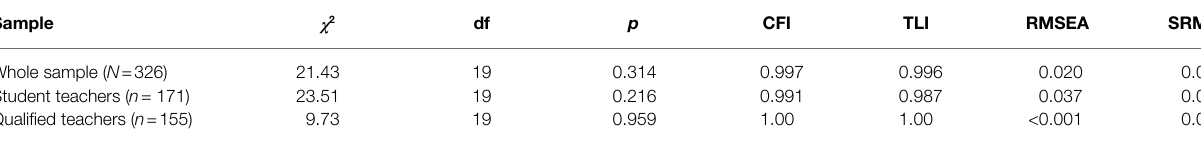
TABLE 3 | Fit indices of Culturally Inclusive Pedagogy: one-factor model. Sample χ 2 df CFI Whole sample ( N = 326)